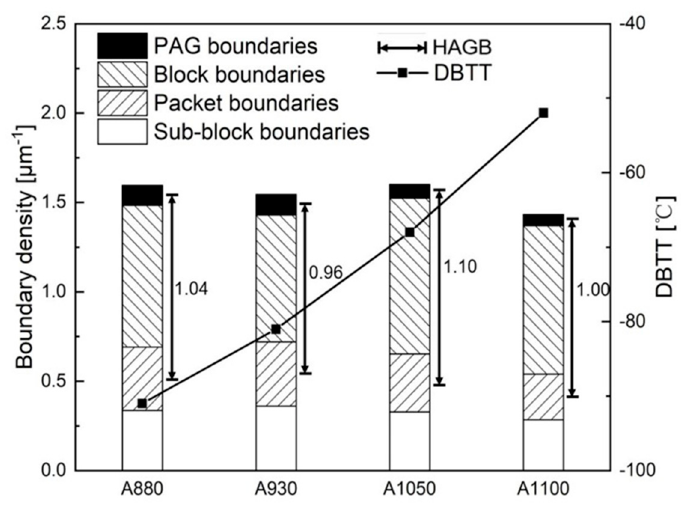
Figure 11. Grain boundaries density of different types and DBTT in experimental steels.